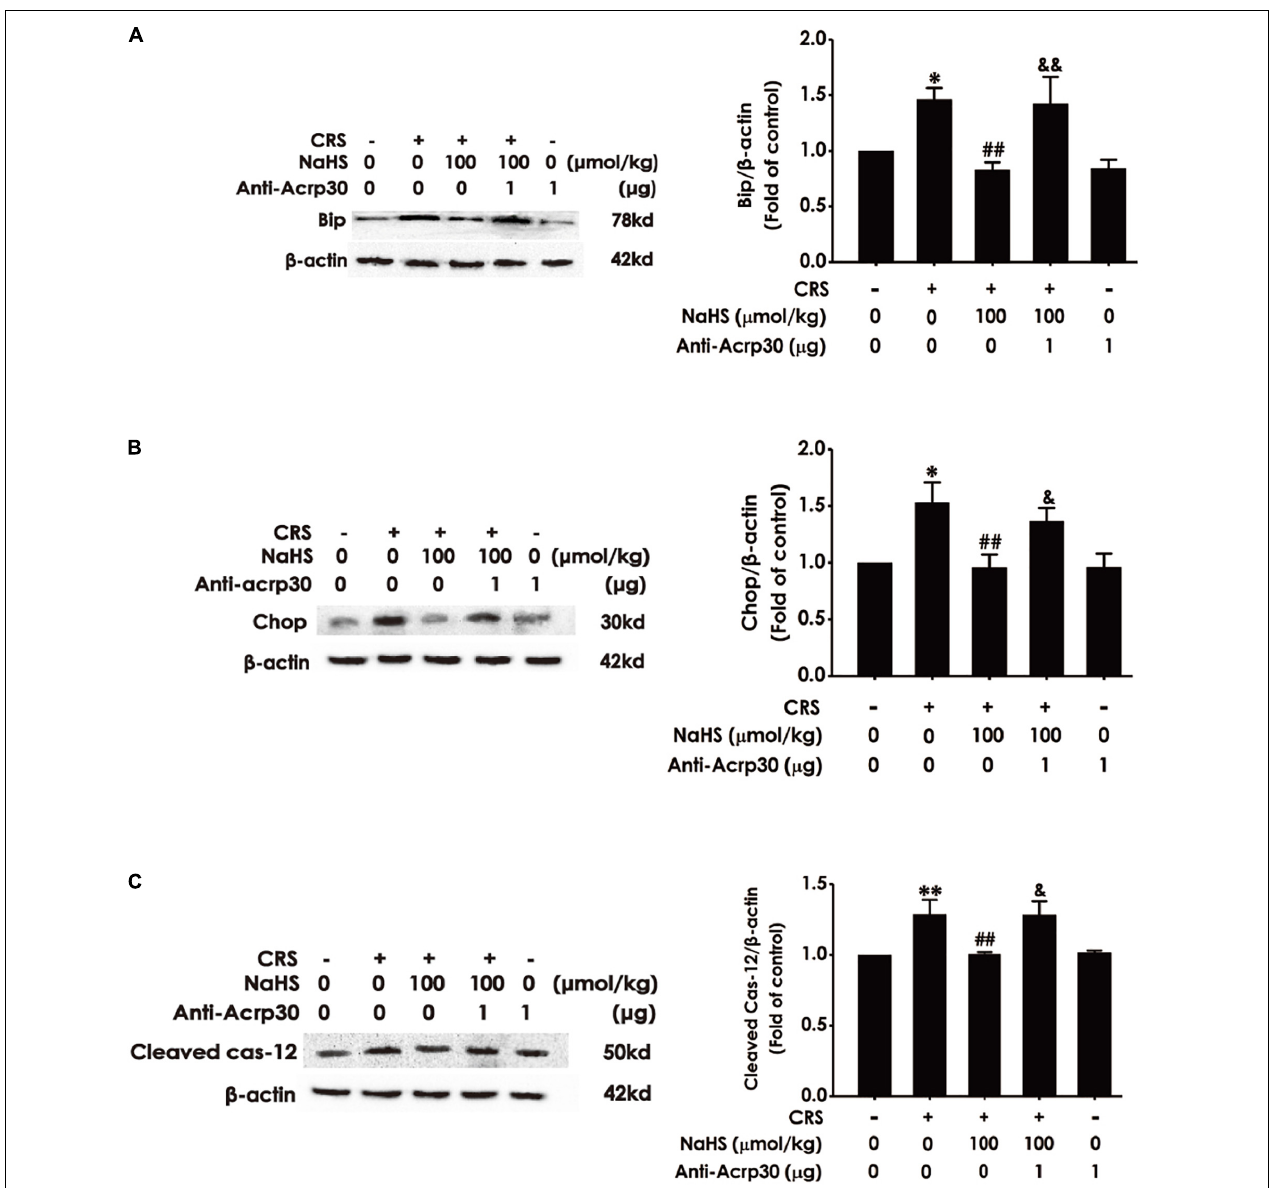
FIGURE 7 | Effects of Anti-Acrp30 on NaHS-meliorated hippocampal ER stress in CRS-treated rats. Rats were co-treated with NaHS (100 µ mol/kg/day, i.p.) and CRS (6 h/day) for 3 weeks, and then co-administrated with Anti-Acrp30 (1 µ g/day, i.c.v.) for further 1 week. The expressions of hippocampal Bip (A) , Chop (B) , and Cleaved Caspase-12 (C) were measured by Western blot analysis. Date are the means ± SEM ( n = 3–4/group). * P < 0.05, ** P < 0.01 vs. control group; ## P < 0.01, vs. CRS-exposed alone group; & P < 0.05, && P < 0.01, vs. co-treatment with NaHS and CRS